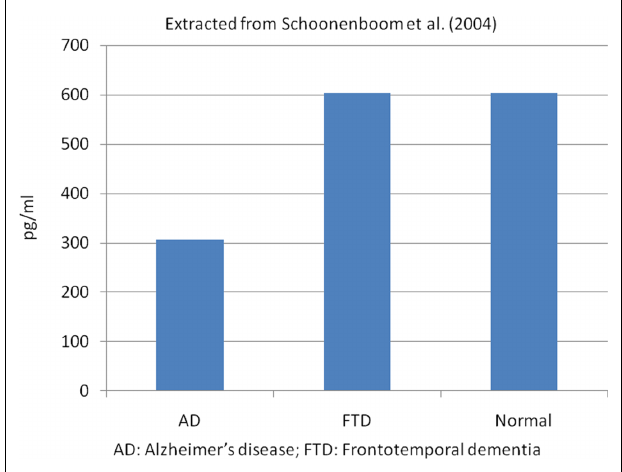
FIGURE 2 | Mean CSFA β 42 levels in autopsied proven cases. Extracted from Schoonenboom et al. (2004). AD, Alzheimer’s disease; FTD, frontotemporal